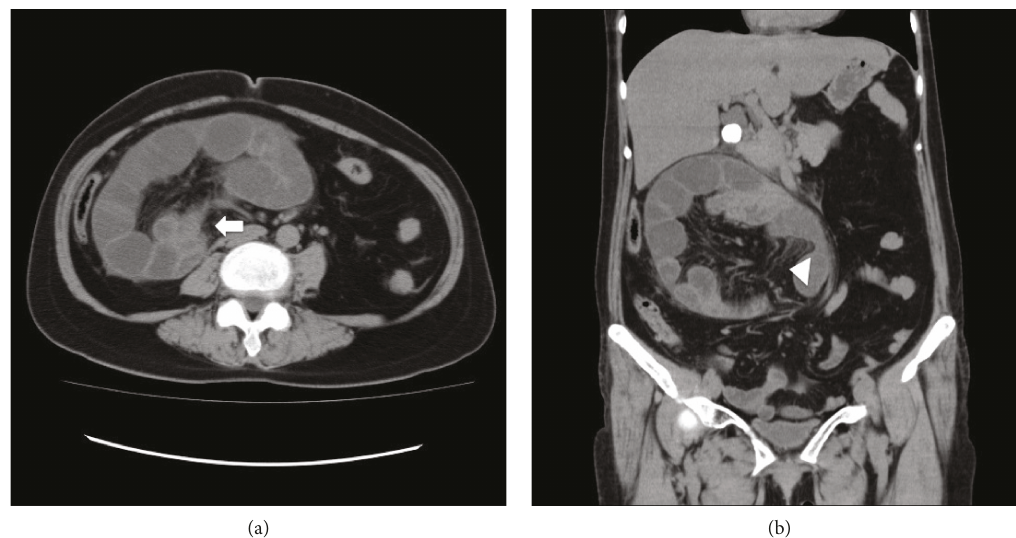
Figure 1: Abdominal CT (noncontrast-enhanced) fi ndings in this patient. (a) Axial image showing that most of the small intestine was located in the right upper abdominal cavity and had a sac-like appearance (arrow). Ascites was observed within the sac. (b) Coronal image showing absence of the ligament of Treitz in the duodenum, along with a fl attened inferior vena cava and distorted mesenteric veins (arrowhead). A 2cm-sized gallstone was also observed.